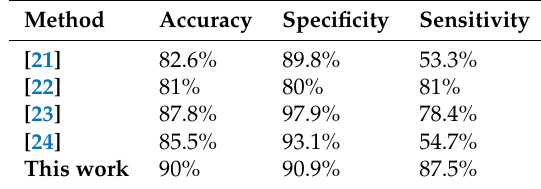
Table 1. Comparison between the proposed method and works from literature.